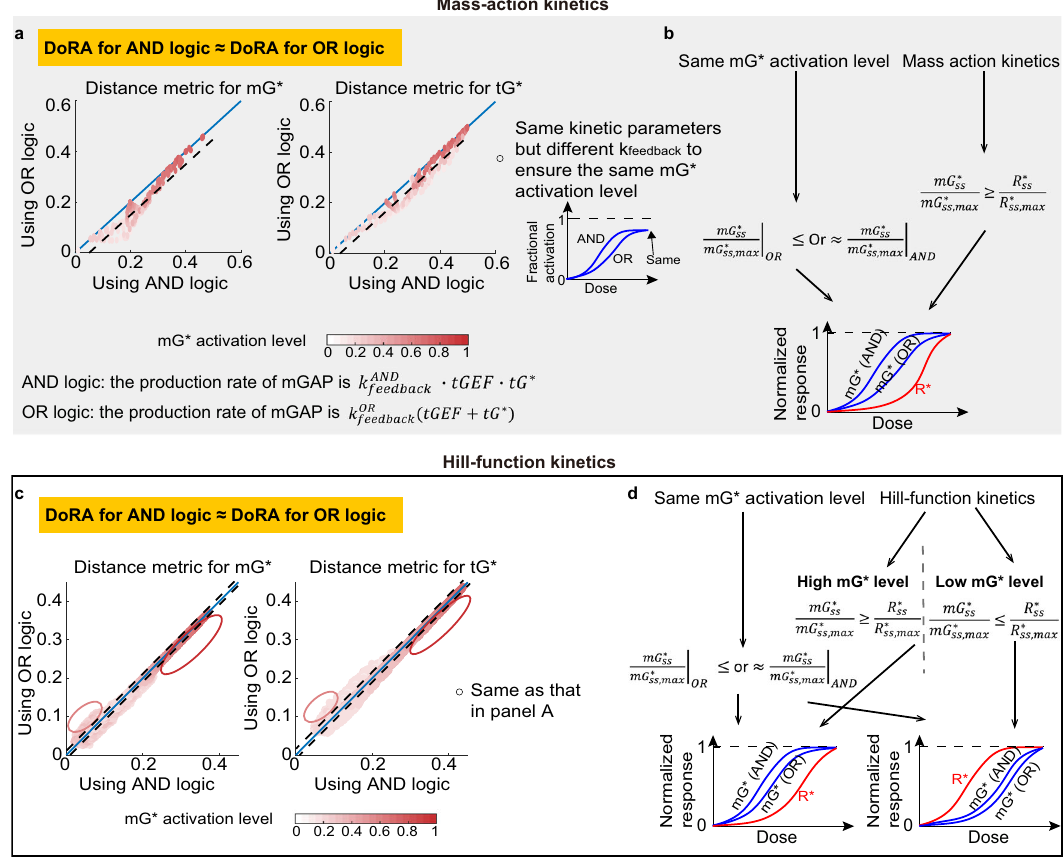
(the value when the ss ; max